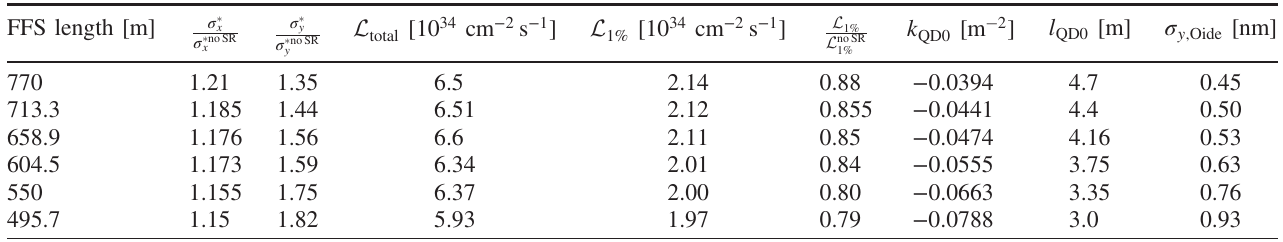
TABLE VII. Luminosity performance, synchrotron radiation impact, and QD0 parameter comparisons for different FFS lengths with L (cid:1) ¼ 6 m. FFS length